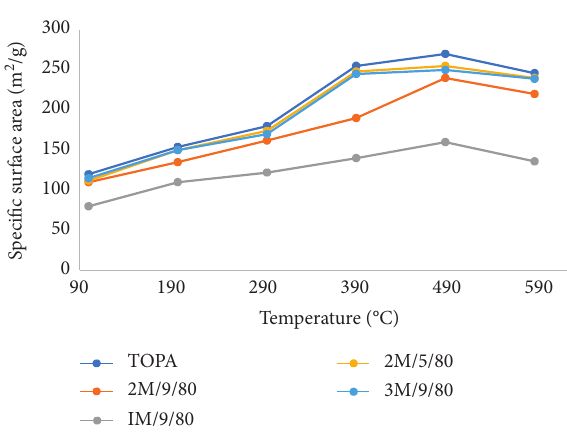
Figure 7: Temperature versus specific surface area for synthesized zeolite Y